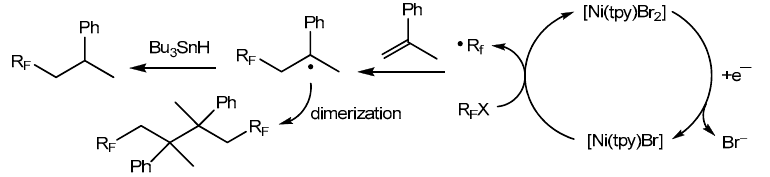
Scheme 20. Proposed reaction sequence in the electrocatalytic fluoroalkylation of α -methyl styrene using [Ni(tpy)Br 2 ], adopted from ref.